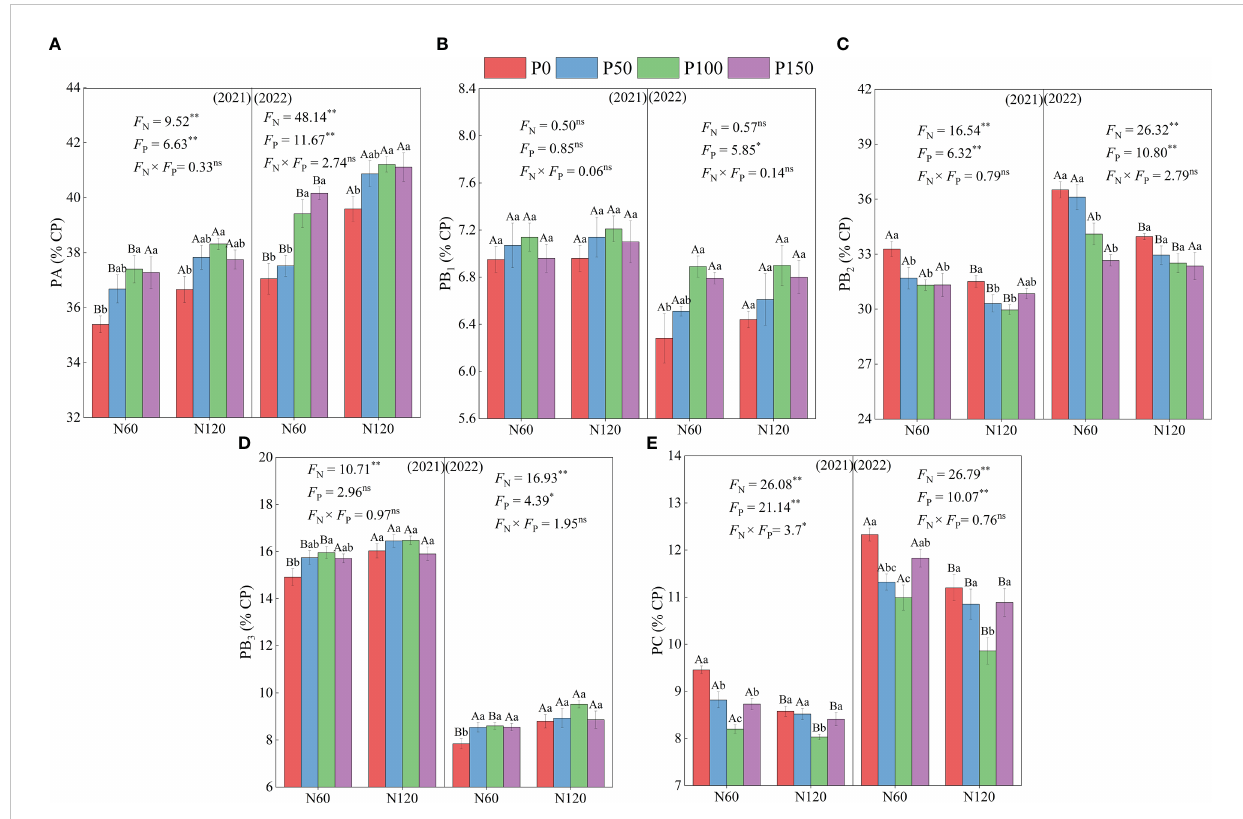
FIGURE 2 Effect of nitrogen and phosphorus combined fertilization on protein fraction of PA = non-protein nitrogen of crude protein (A) , PB 1 = easily degradable protein (B) , PB 2 = intermediately degradable protein (C) , PB 3 = slowly degradable protein (D) , and PC = non-degradable protein (E) of alfalfa. Different small letters indicate signi fi cant differences between different P fertilizer treatments under the same N application condition ( p < 0.05). Different capital letters indicate signi fi cant differences between different N fertilizer levels under the same P application condition ( p < 0.05). F N , F P and F N × F P represent the F value under the N application levels, P application levels and the interaction of N and P application levels, respectively. ns indicates no signi fi cant difference ( p > 0.05), * indicates signi fi cant difference ( p < 0.05) and ** indicates extremely signi fi cant difference ( p <